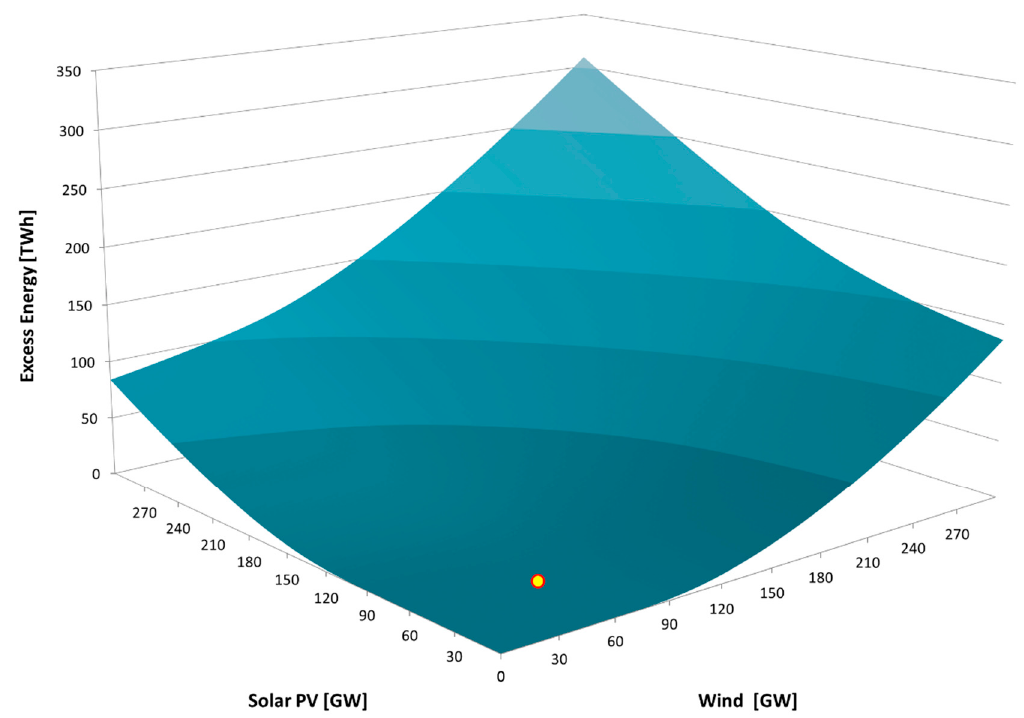
Figure 5. Excess energy (EE) surface plot Case B including the 2017 capacities from wind and solar PV (point marking).